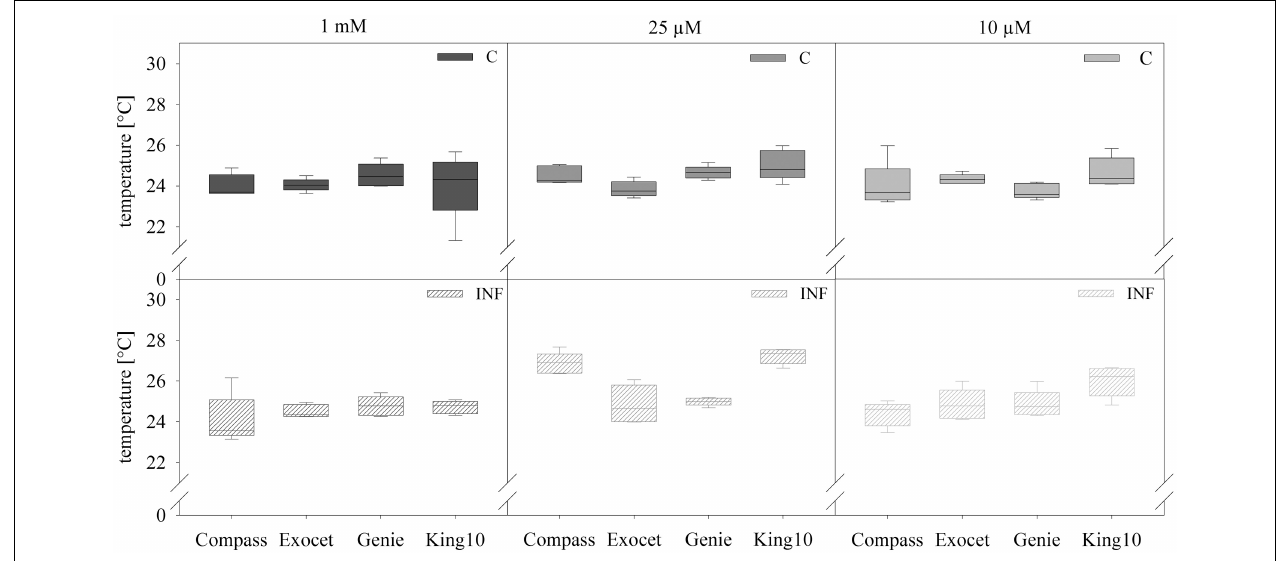
plots of five plants per treatment with 10 dots chosen on fully expanded leaves. Filled boxes present non-infected plants (C) and striped boxes the corresponding results of infected plants (INF).